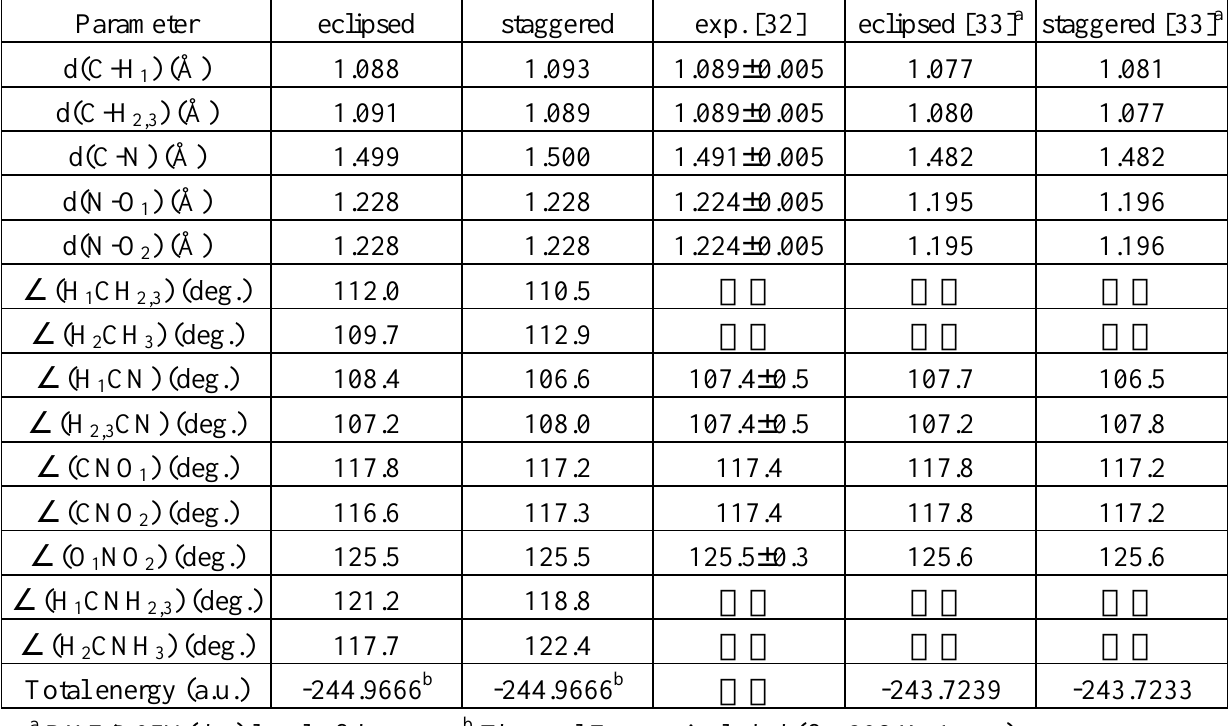
Table 1. Geometric parameters and total energy for the nitromethane molecule calculated using the B3LYP method and the 6-31+G* basis